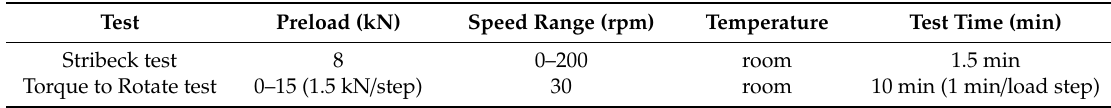
Table 5. Friction torque test